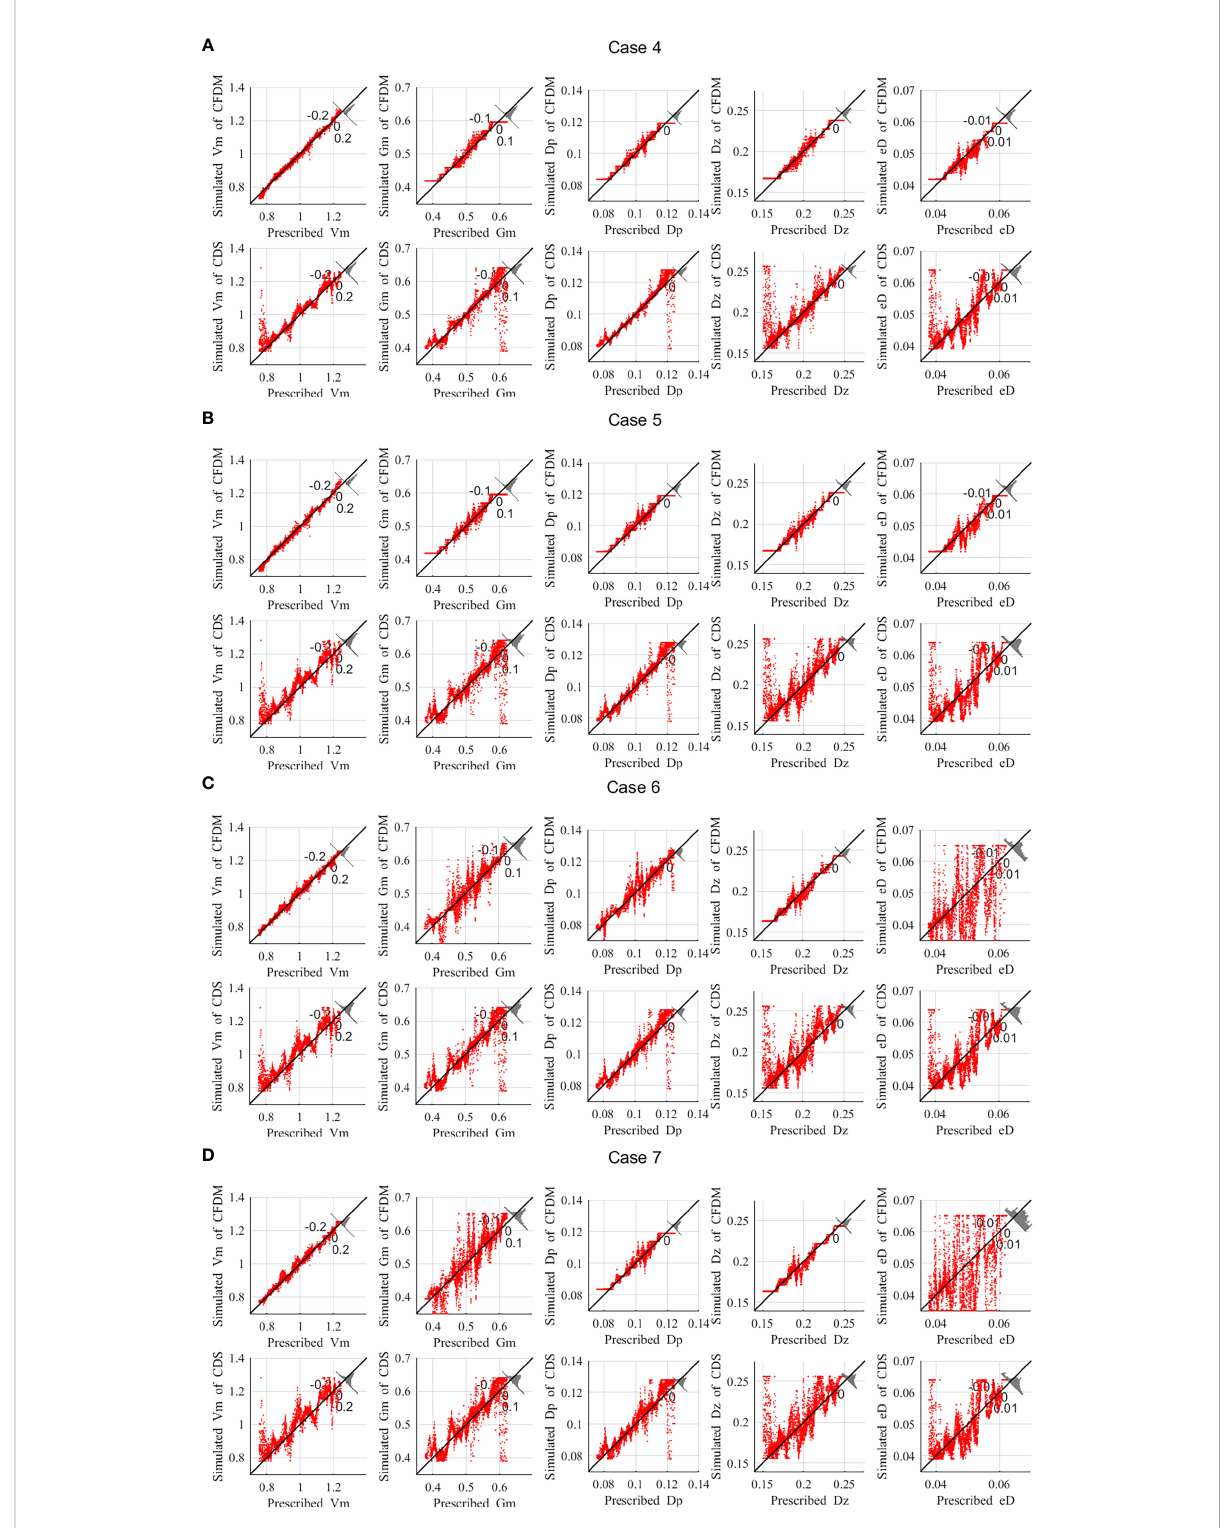
FIGURE 6 Comparison of the fi ve parameters obtained by the CFDM and CDS method and the prescribed values in (A) Case 4, (B) Case 5, (C) Case6, (D) Case 7. This image shows the mis fi ts between the estimations and their real values. (unit: day −